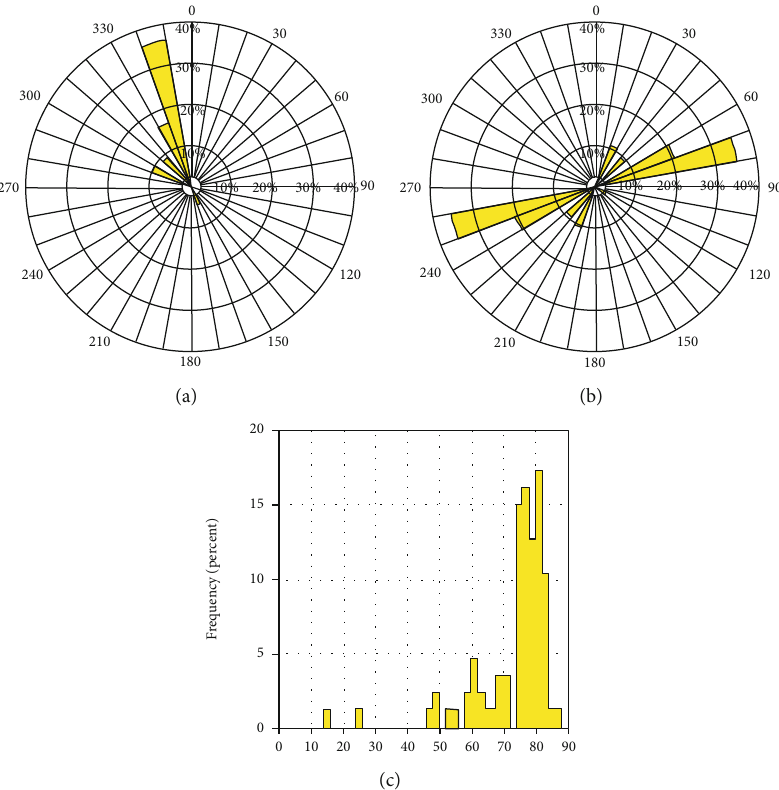
Figure 8: Fracture statistics of well XN111. (a) rosette (azimuth); (b) rosette (strike); (c) dip (degree).